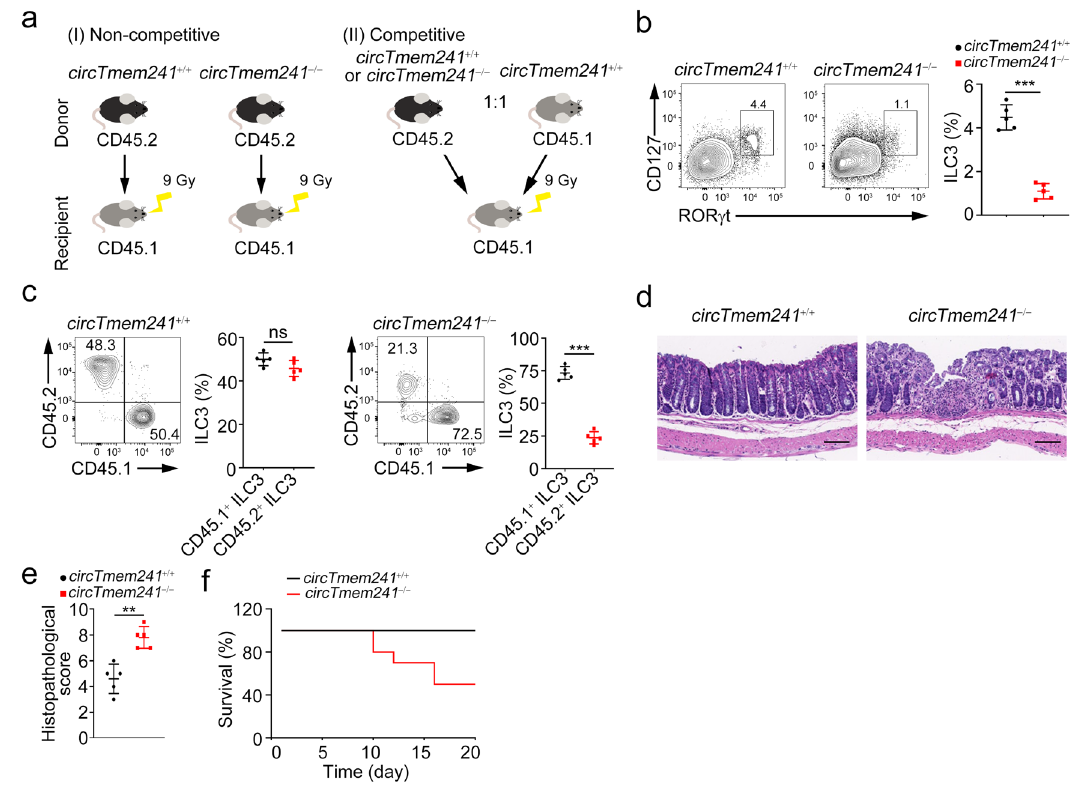
Fig. 3 | CircTmem241 regulates ILC3 commitment in an intrinsic